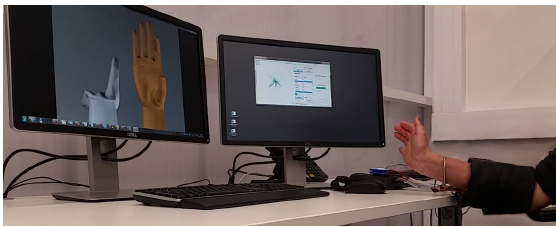
Figure 4. Training part of the experiment: the participant imitates the grey animated hand model.